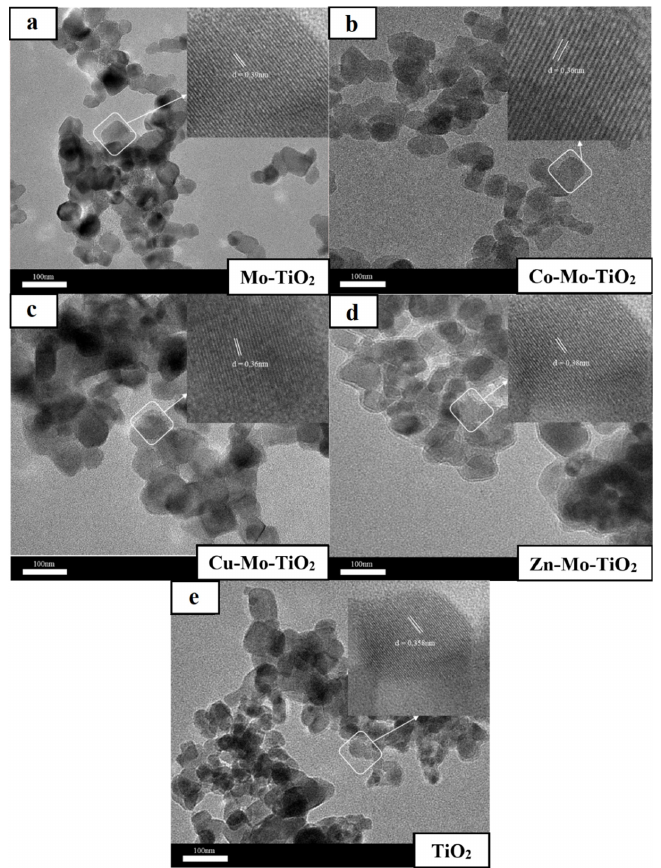
Figure 8. TEM analysis of ( a ) Mo-TiO 2 , ( b ) Co-Mo-TiO 2 , ( c ) Cu-Mo-TiO 2 , ( d ) Zn-Mo-TiO 2 , and ( e ) TiO 2 .